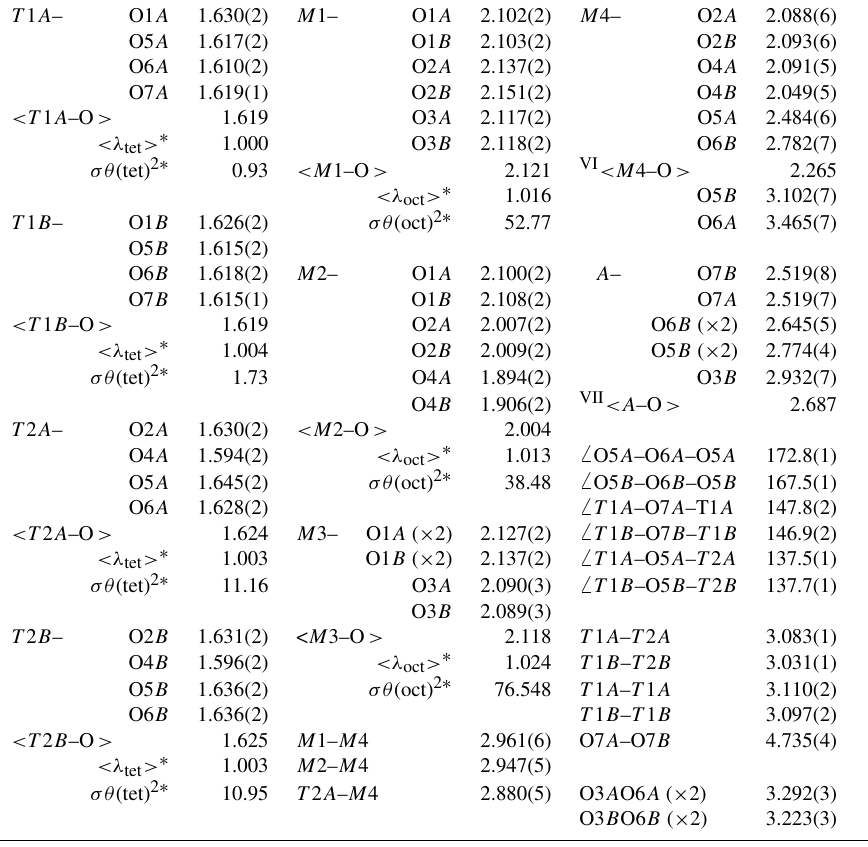
Table 7. Selected bond lengths (Å) and angles ( ◦ ) of ferro-ferri-holmquistite.